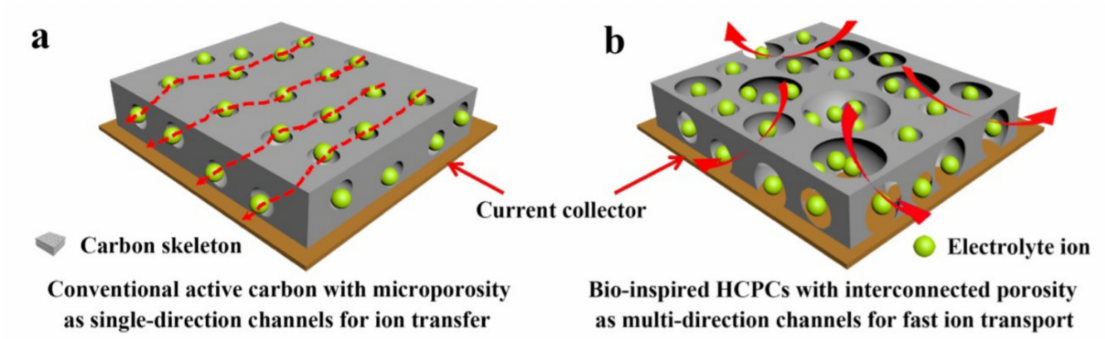
Figure 5. Scheme of di ff erent ion channels in ( a ) conventional AC with single direction porosity and ( b ) HCPC with multidirectional porosity for ion transfer. Figure reproduced from reference [68] with permission from Americam Chemical